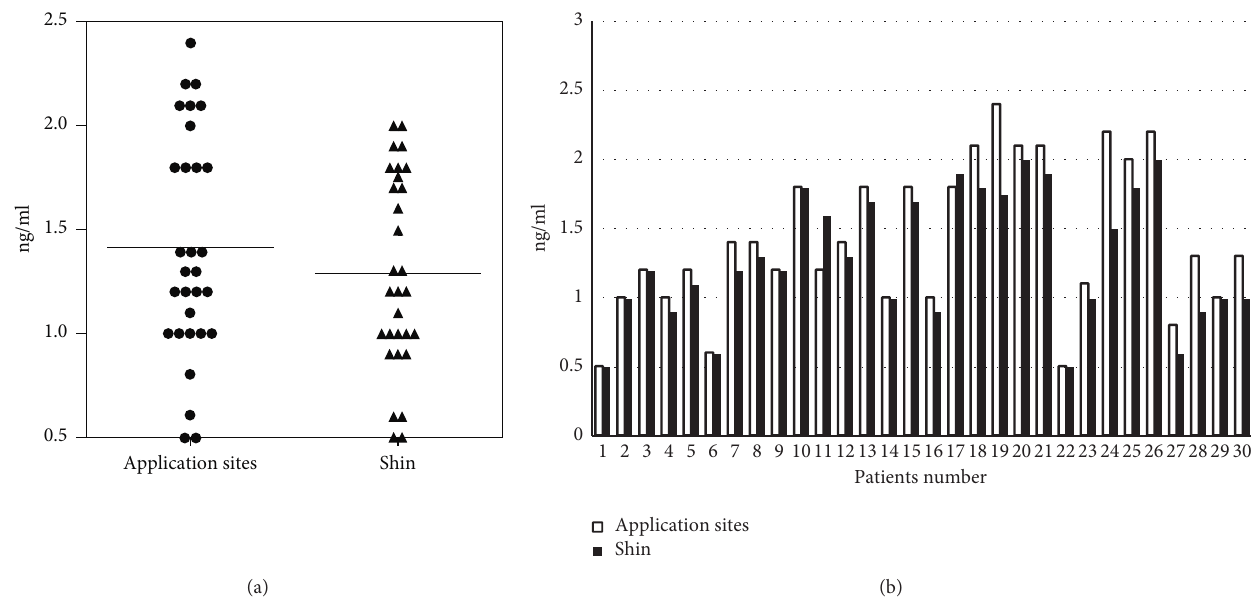
Figure 5: The mean plasma rotigotine concentration in the pre-RTP group was significantly lower than that in the post-RTP group (a) ( p < 0 . 005). The plasma rotigotine concentration was reduced in 19, increased in two, and not changed in nine patients